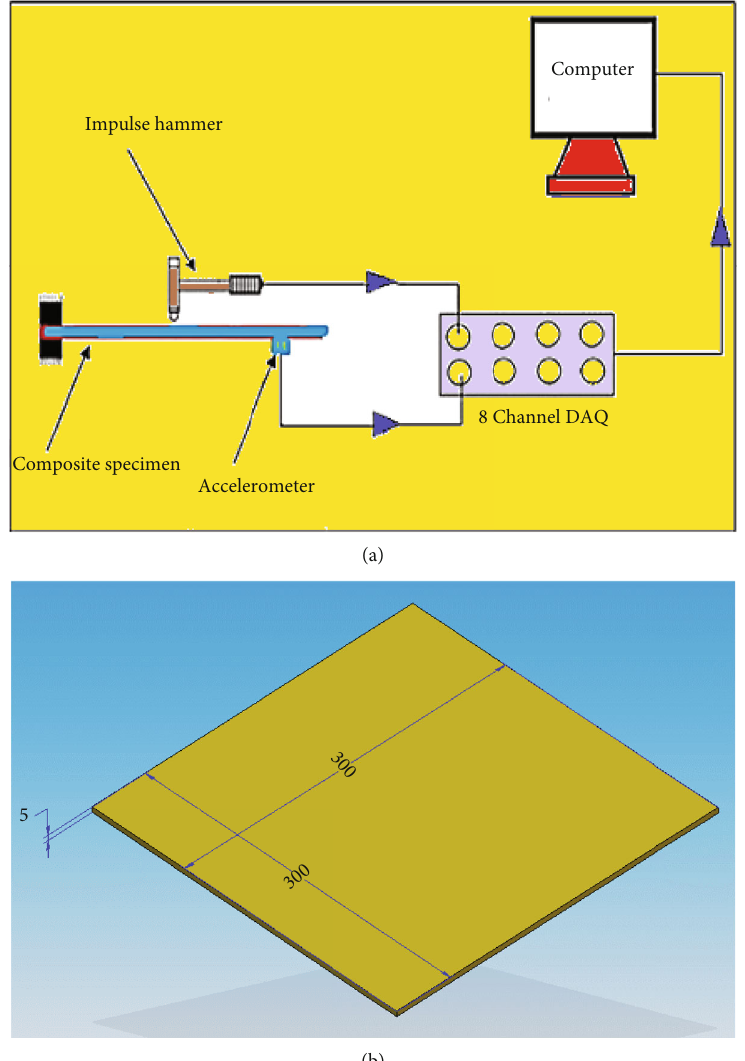
Figure 2: (a) Schematic of the free vibration test setup used in the present work. (b) 3D model of the vibration test